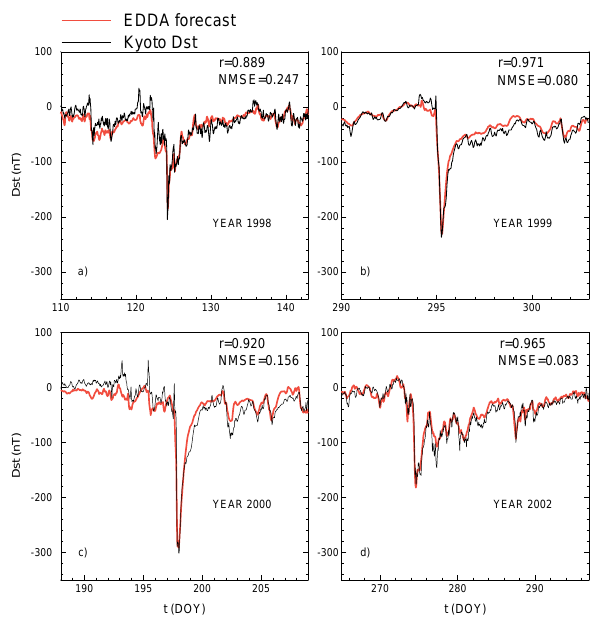
Fig. 4. Comparison of the EDDA D st (red lines) with the Kyoto D st (black lines) for geomagnetically disturbed periods. r is the linear correlation coefficient and NMSE the normalised mean square error (see text for